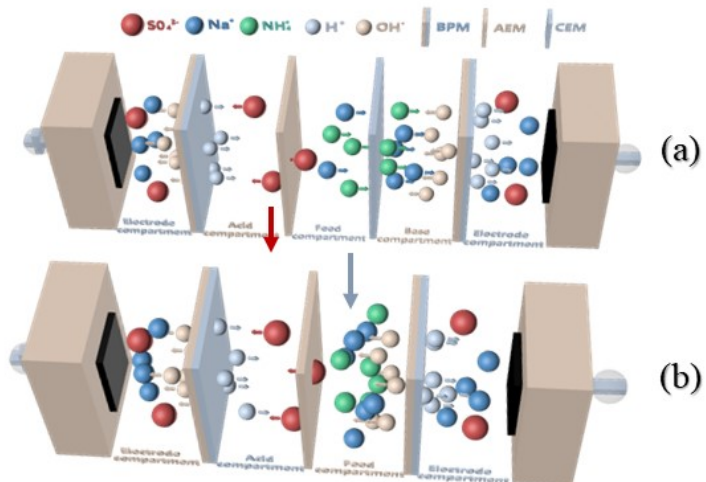
Figure 1. Schematic representation of bipolar membrane electrodialysis (BMED) configuration with three ( a ) and two compartments ( b ).